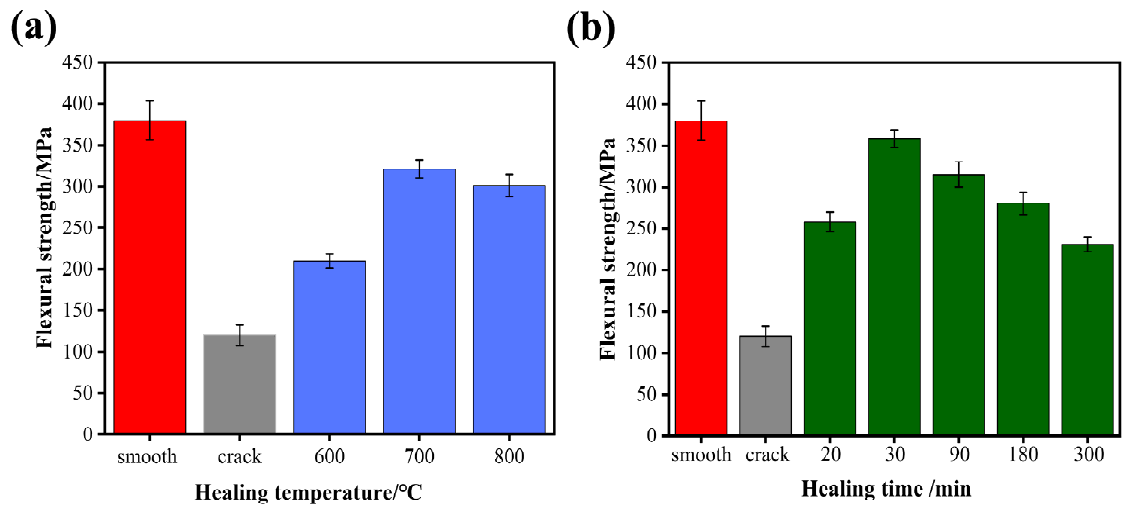
Figure 6. The flexural strength recovery of cracked specimens under different ( a ) healing temperature for 60 min, and; ( b ) healing time at 700 °C.